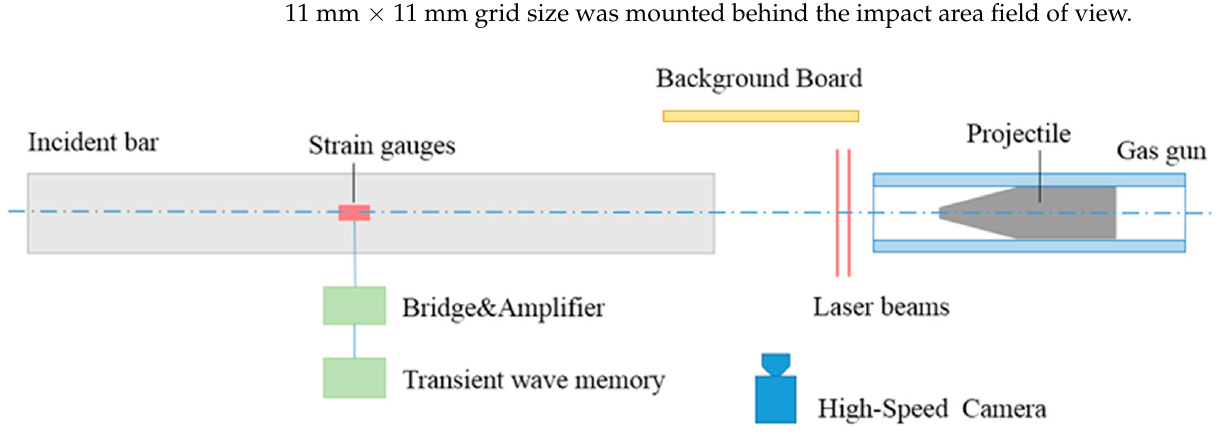
Figure 5. Schematic of the experiment layout.